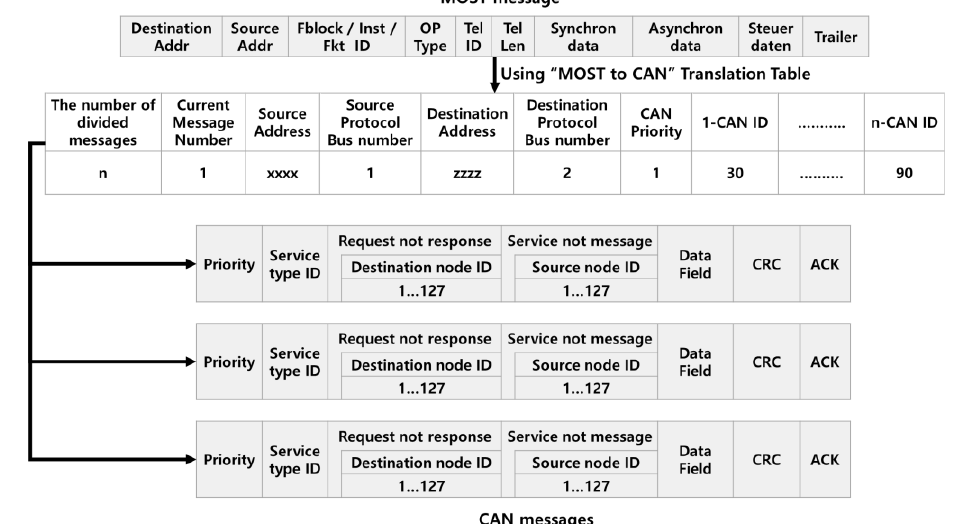
Figure 7. The Translation of MOST into CAN message by the Translation Table.